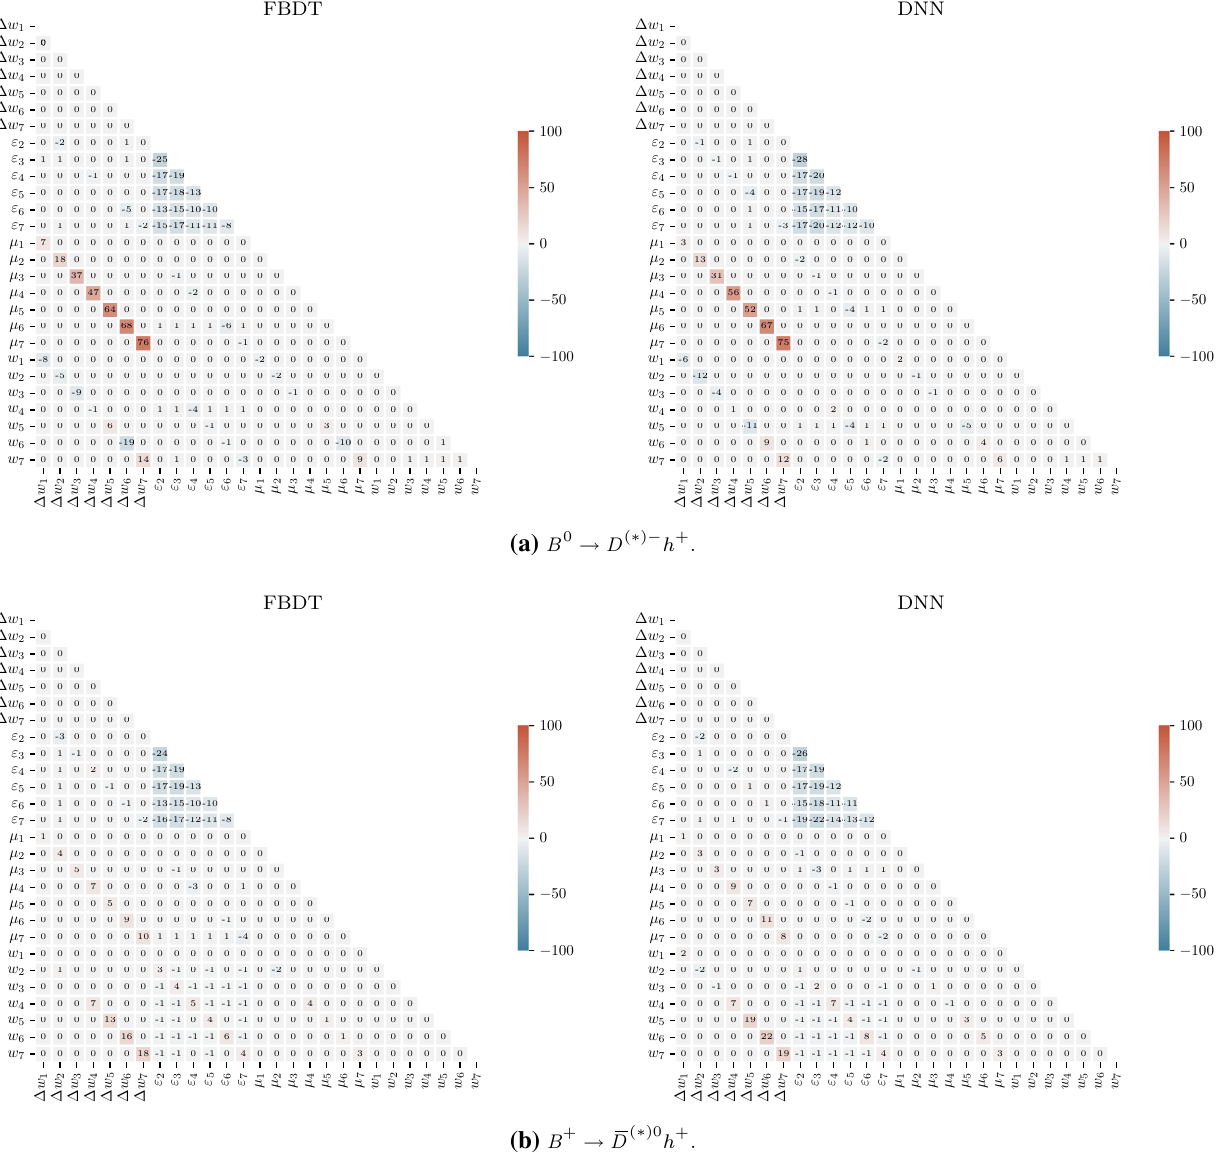
Fig. 12 Correlation coefficients between ε i , Δw i , Δw i , and μ i for the (left) category-based and (right) DNN flavor tagger in data. The results are shown for (top) neutral and (bottom) charged B → D